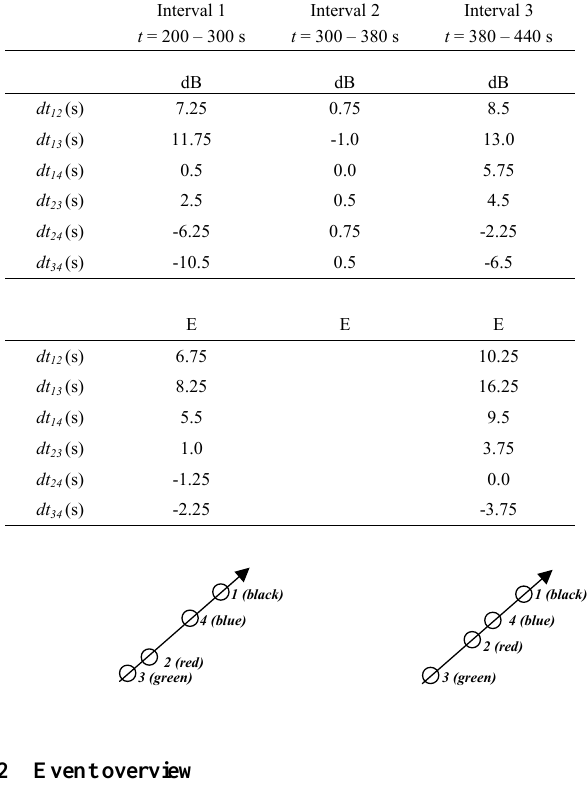
Table 1. Results of cross correlation analysis.